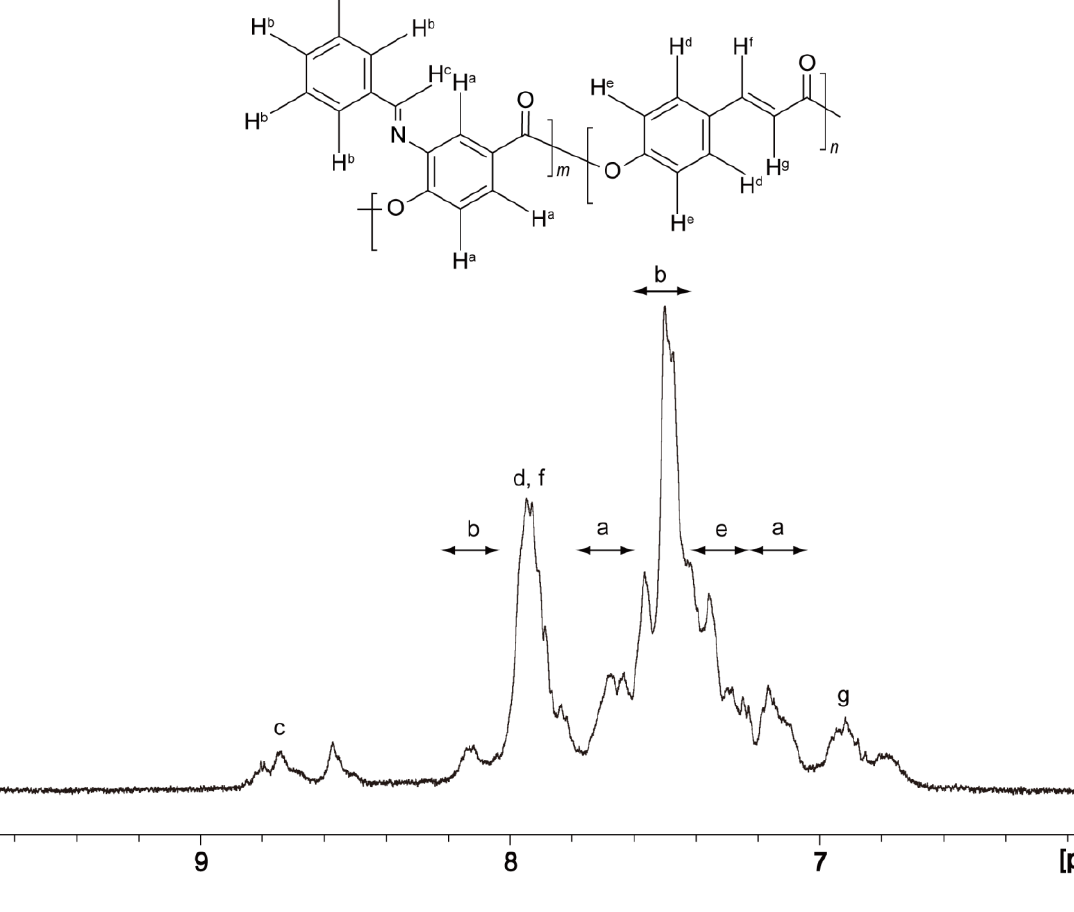
Figure 2. 1 H-NMR spectra of Poly(3,4-BAHBA -co- 4HCA) with a 4HCA composition of 50 mol% 4HCA in DMSO- d 6